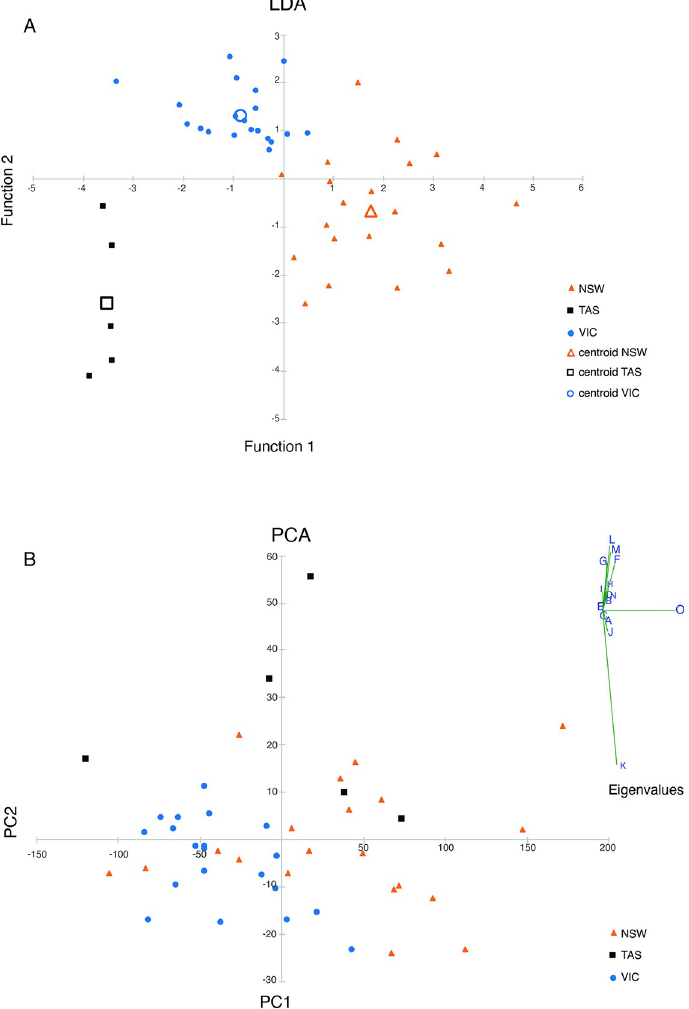
Fig 5. Linear Discriminant Analysis (LDA) and Principal Component Analysis (PCA) of morphological measurements. (A) LDA biplot of Function 1 vs Function 2 with centroids indicated, and (B) PCA biplot of PC1 vs PC2, loadings of each seadragon specimen using the suite of external metrics from Fig 2. Eigenvalues are indicated for PCA, prominent eigenvalues are total length (O), measure of tail (K) and two body depth (L, M). Symbols: Brown triangles NSW, blue circles VIC, and black squares TAS specimens. Centroids of LDA are indicated for each group are open using same shape and